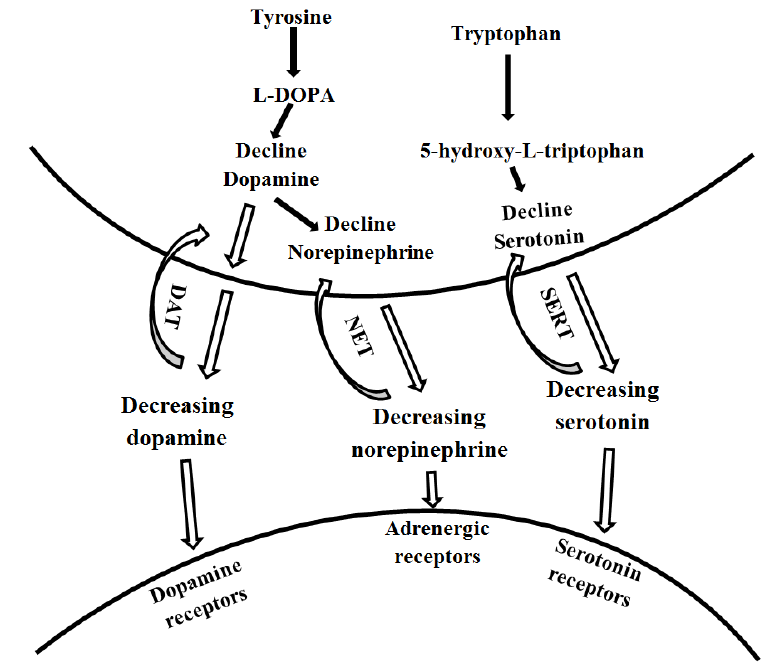
Figure 3. Role of monoamine system in the pathophysiology of post-stroke depression. A schematic mechanism of decreasing concentration of monoamines in the synaptic cleft. (DAT — Dopamine transporter, NET — norepinephrine transporter, SERT — serotonin transporter) .